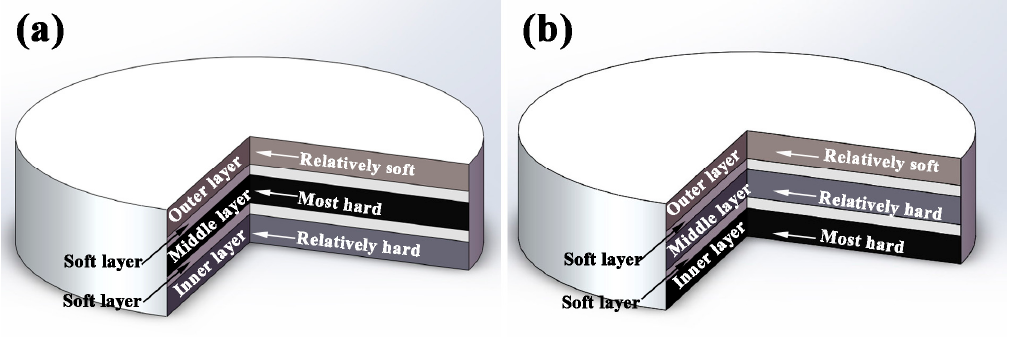
Figure 2. Schematic diagrams of bionic coupling models based on ( a ) Meretrix lusoria shell and ( b ) Rapana venosa shell.